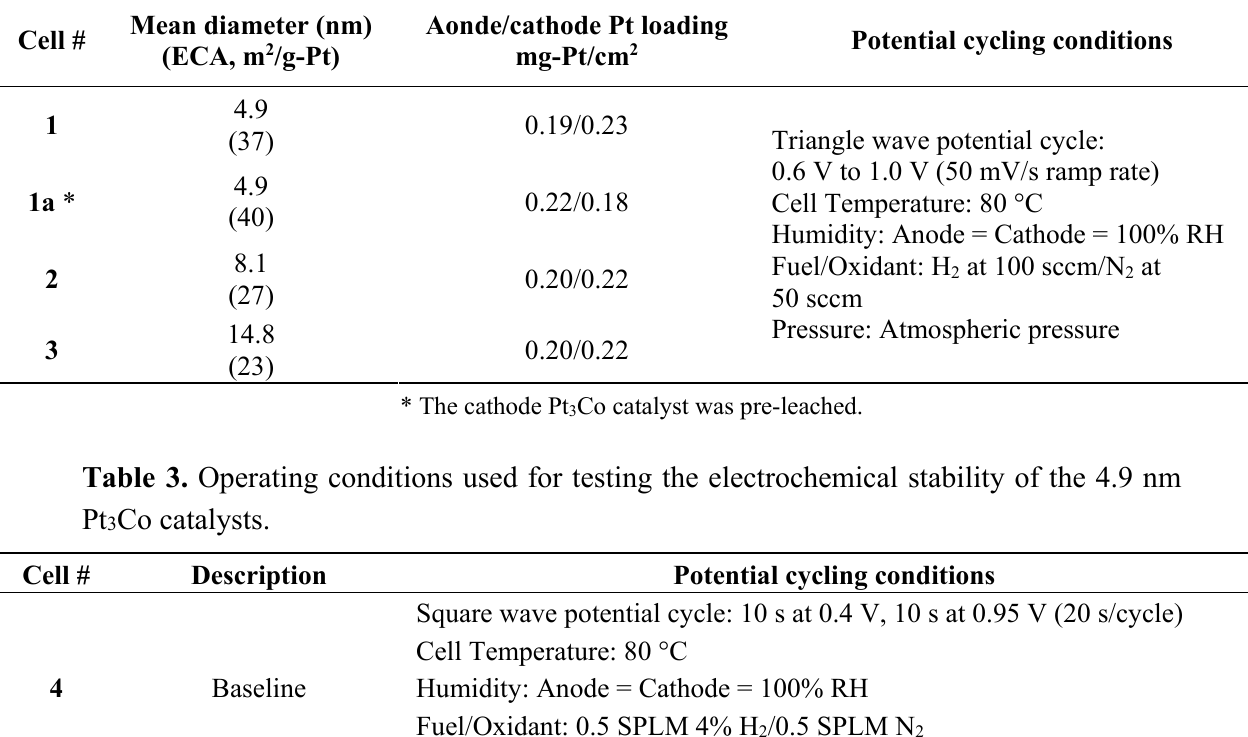
Table 2. Pt 3 Co catalyst particle sizes used in this study and cycling conditions used to test their electrochemical stability. Note that the ECA values reported are the peak ECA’s.